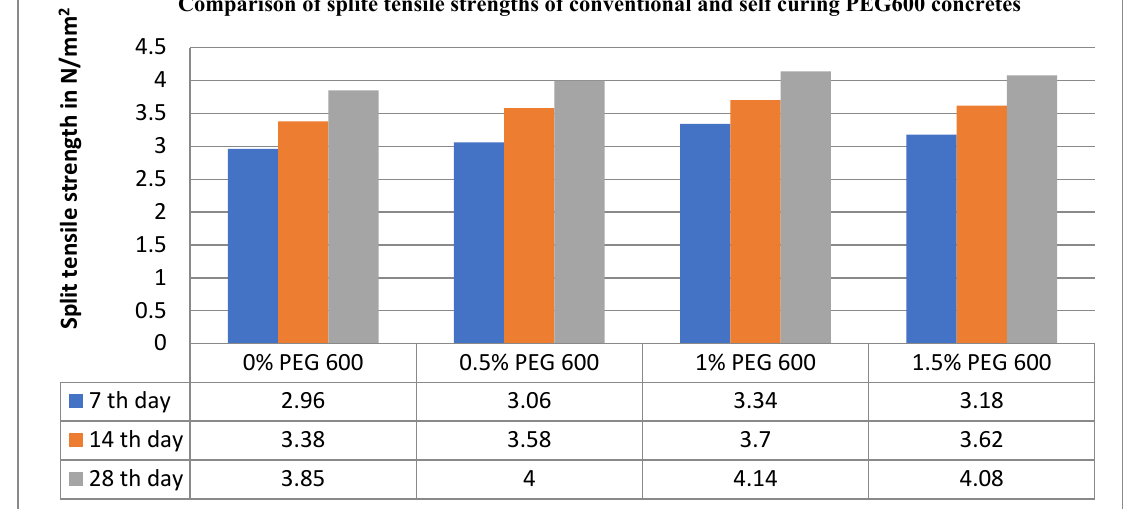
Comparison of splite tensile strengths of conventional and self curing PEG600 concretes